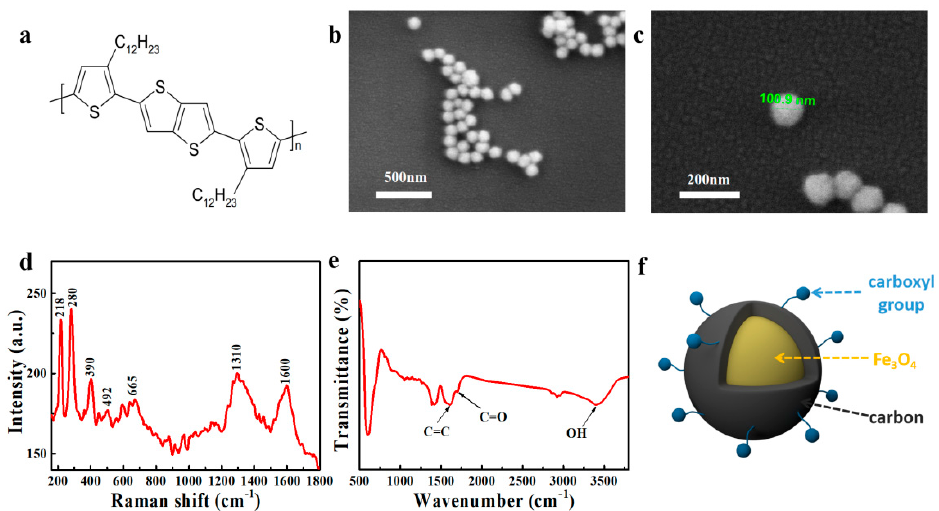
Figure 1. ( a ) Chemical structures of PBTTT; ( b , c ) SEM images of Fe 3 O 4 @C nanoparticles; The Raman profile spectrum ( d ) and FT-IR spectrum ( e ) of Fe 3 O 4 @C nanoparticles, respectively. ( f ) 3D model of Fe 3 O 4 @C nanoparticles.